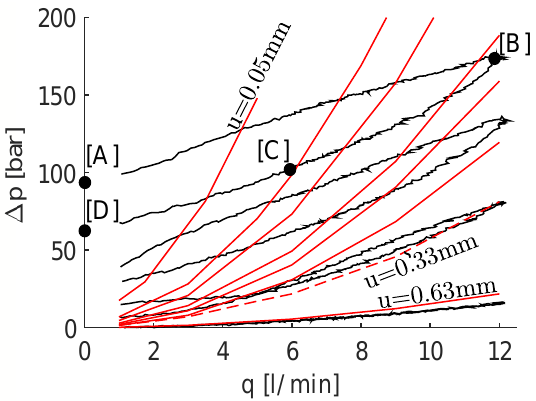
Figure 13: ∆ p (q) for the HV data at 40 ◦ C(black). Sim- ulated ∆ p (q) for u ∈ { 0.05, 0.08, 0.10, 0.13, 0.16, 0.20, 0.33*, 0.63 } mm(Red). The u=0.33mm curve is